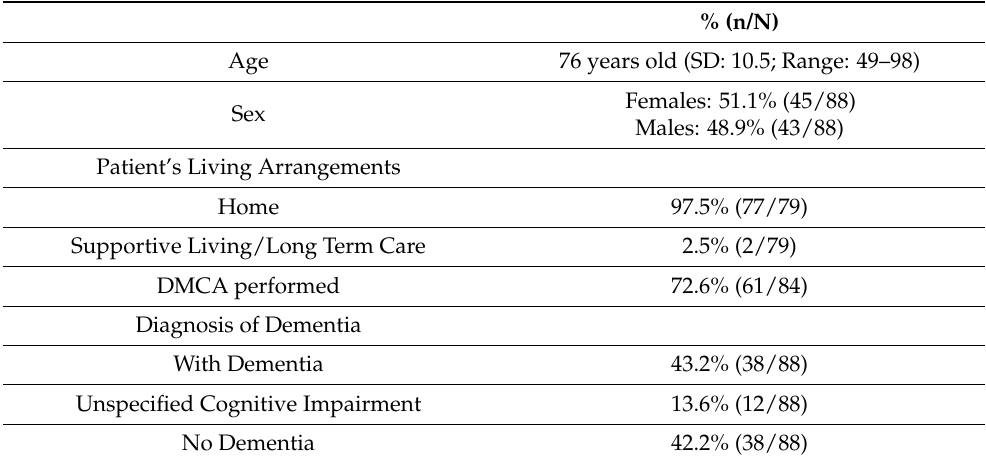
Table 1. Characteristics of patients referred for DMCAs, 2006–2020.